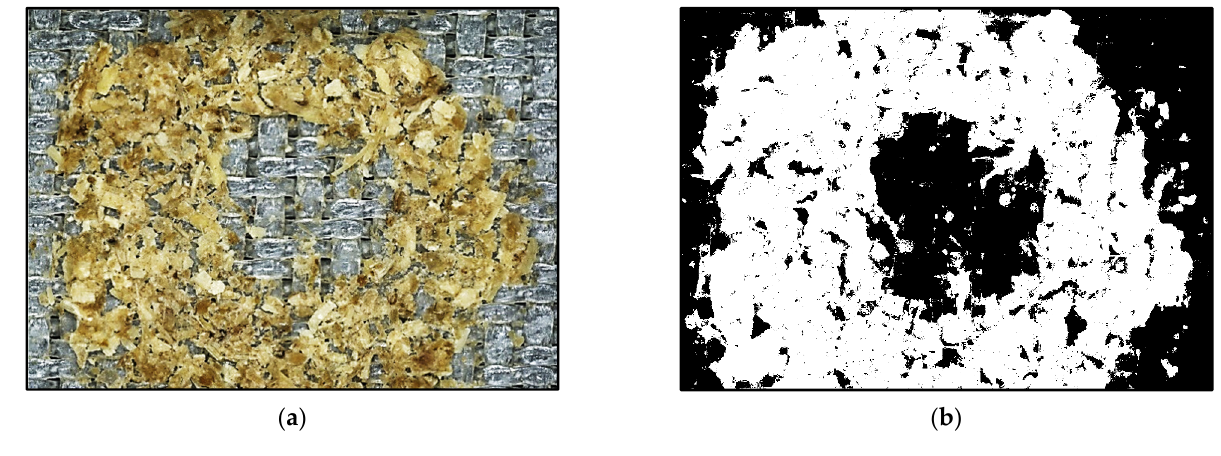
Figure 3. Original image of the cleaned filter sample ( a ) and its binarized image ( b ). The white spots represent the remaining contamination after cleaning, whereas the black areas show the cleaned or contaminated surface. The picture also illustrates the area where the jet streamed through the filter cloth (the black spot in the middle of b).